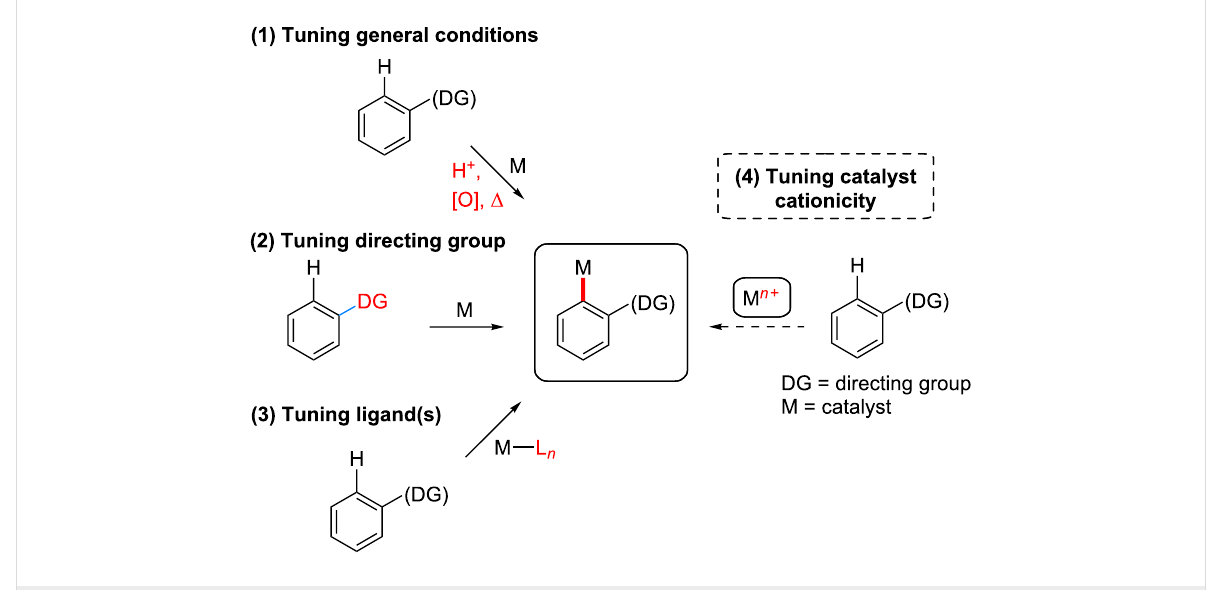
Figure 1: Road map to enhanced C–H activation